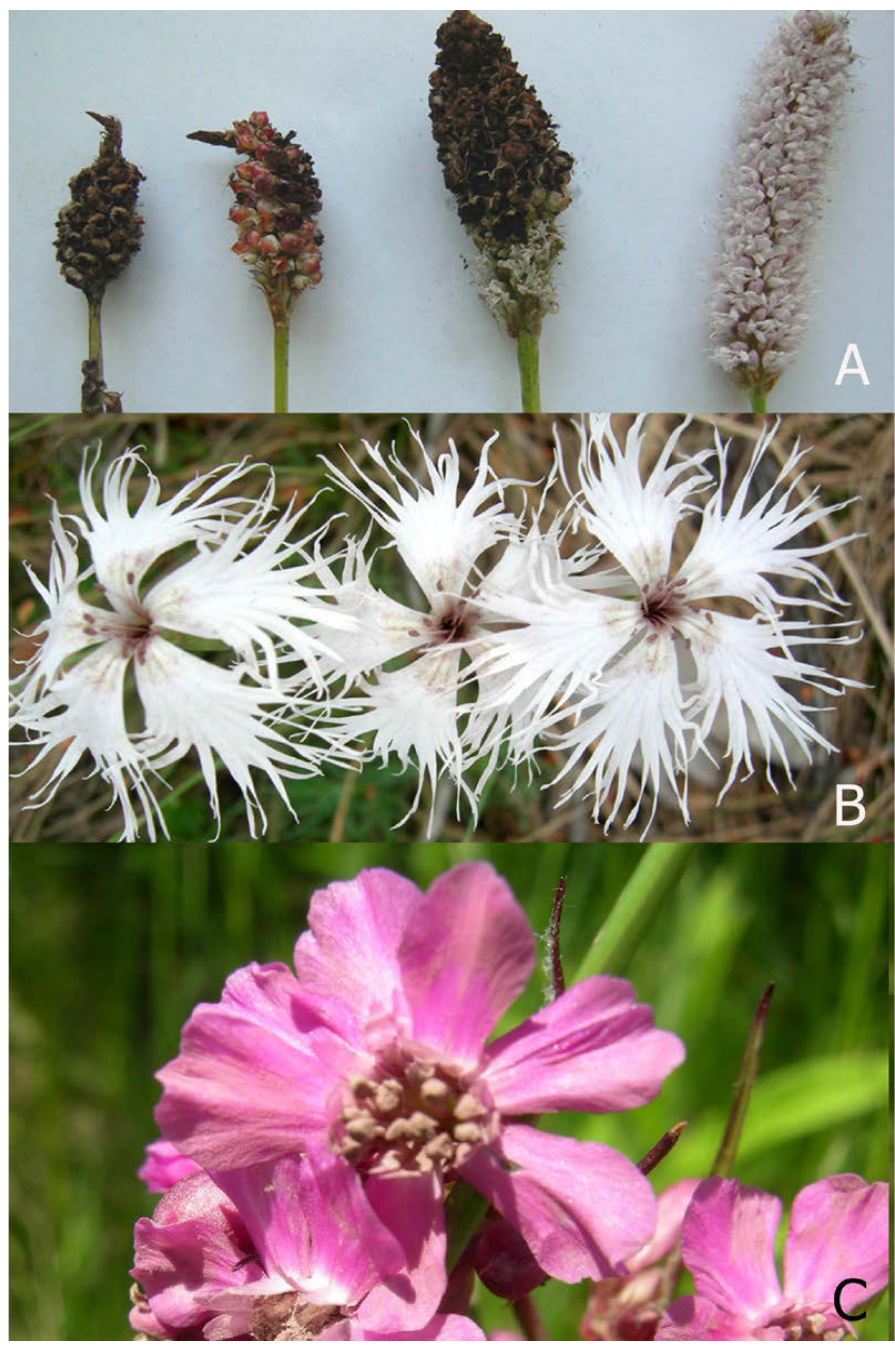
Fig. 1. A – Microbotryum bistortarum in flowers of Polygonum bistorta ; B – M. superbum in anthers of Dianthus superbus subsp. superbus ; C – Microbotryum lagerheimii in anthers of Lychnis viscaria